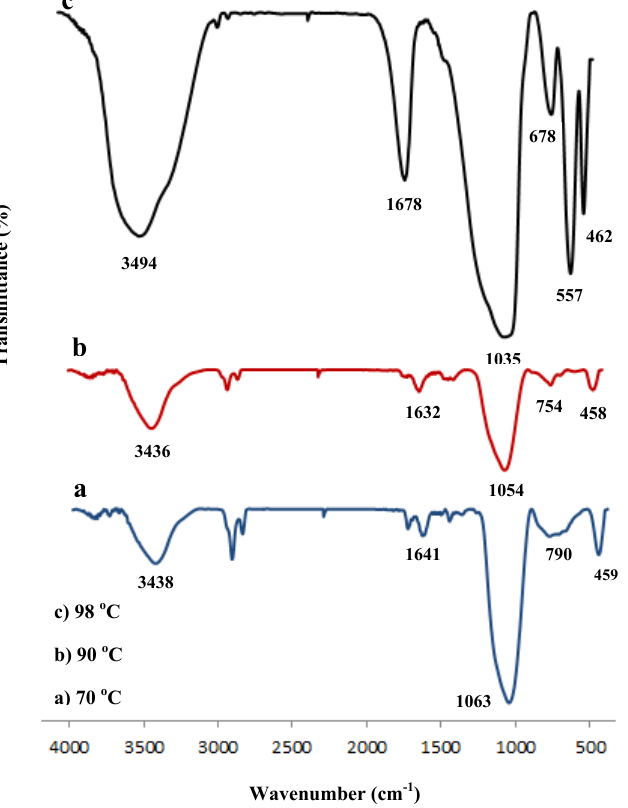
Fig. 7. FT-IR spectra of samples synthesized at 70, 90, 98 o C and 72 h.